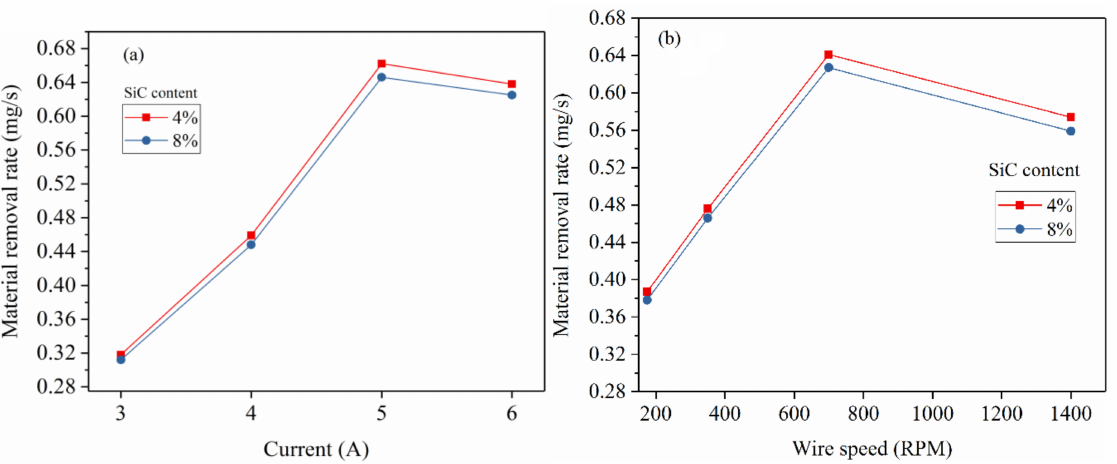
Figure 3. ( a ) The effect of current on MRR. ( b ) The effect of wire speed on